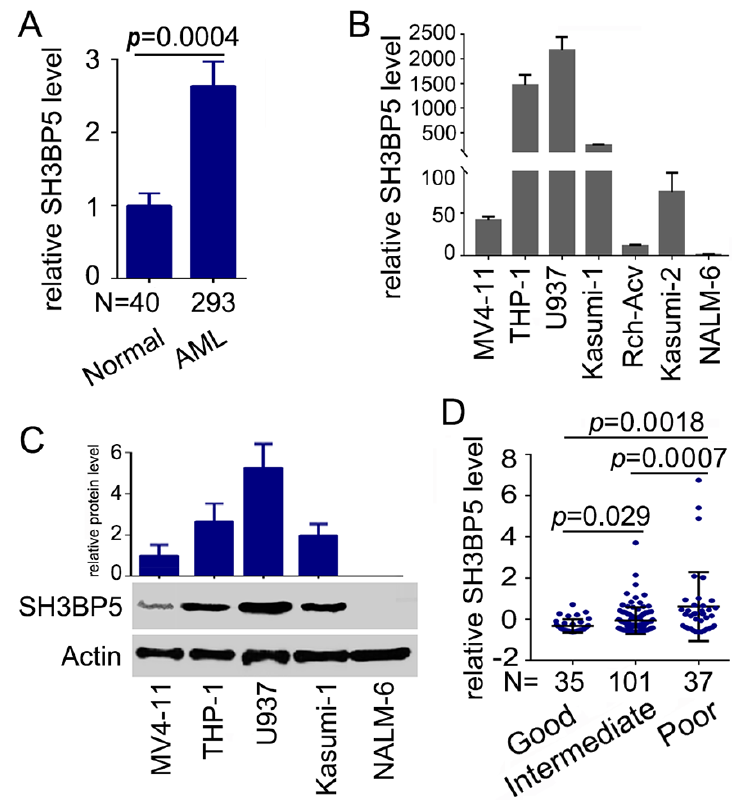
Figure 1. Elevated expression of SH3BP5 in acute myeloid leukemia (AML) cells and